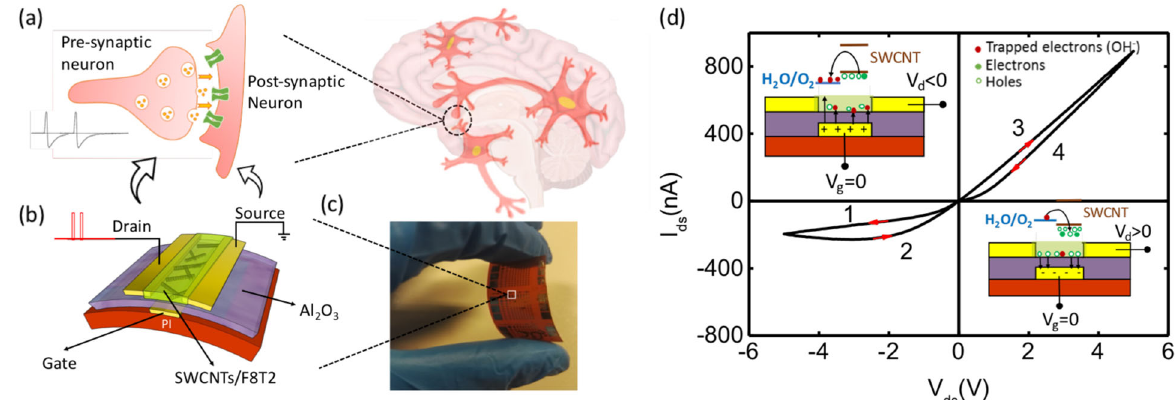
Fig. 1 Schematics and working mechanism. Schematics of ( a ) a biological synapse and ( b ) arti fi cial synapse. c Photograph of fl exible arti fi cial synapses. d Pinched I ds − V ds curve with V g set as 0 V (L = 20 µm, W = 50 µm), and the insets indicate the mechanism of the memristive